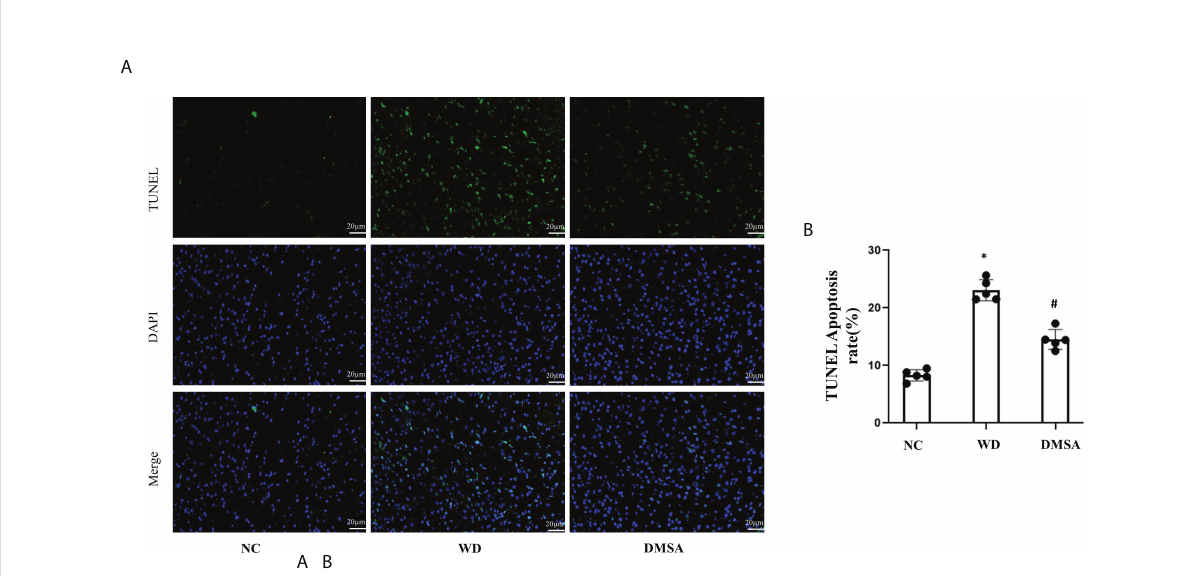
FIGURE 6 Apoptosis of hypothalamus neurons in male mice ( (cid:1)x ± s ). Apoptosis analysis of hypothalamus neurons in male mice (A, B) . Data are presented as mean ± SD.(*P<0.05, NC group vs. WD group; # P<0.05, WD group vs. DMSA